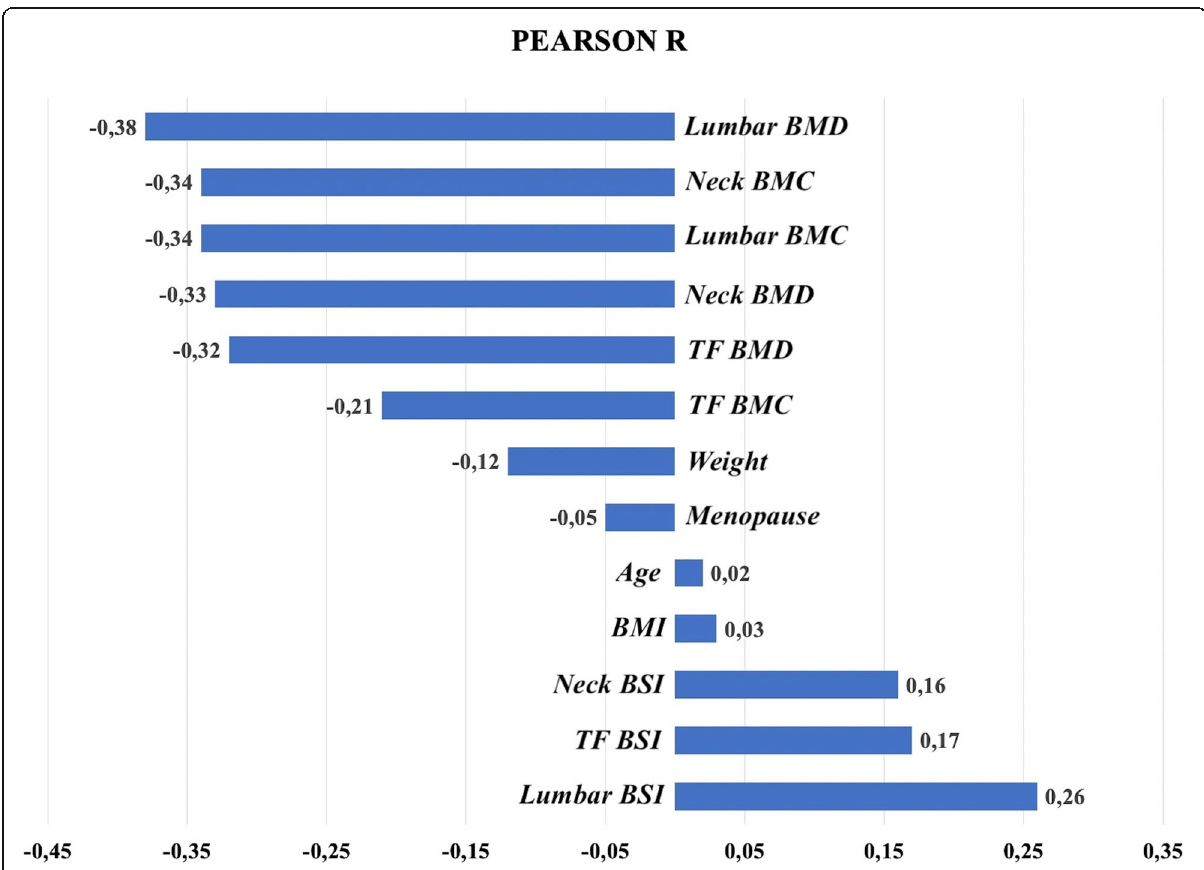
Fig. 3 Linear correlation values (Pearson correlation coefficient) between the study variables and the presence of a vertebral fracture at follow-up. BSI, Bone Strain Index; TF, Total femur; BMI, Body mass index; BMC, Bone mineral content; BMD, Bone mineral